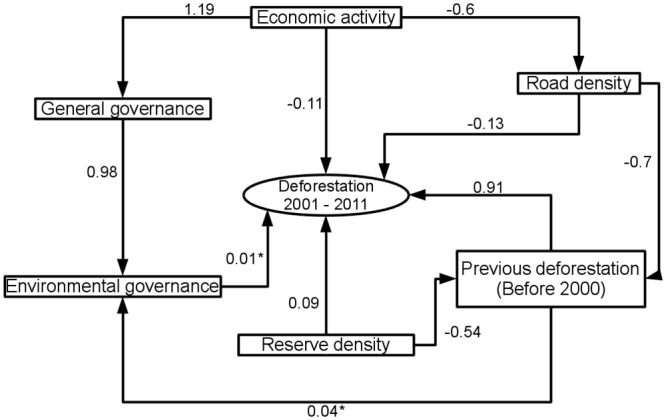
Path analysis results.Each arrow represents a path and its associated path coefficient. Asterisks represent statistically insignificant relationships in simple or multiple regression tests (P > 0.05).